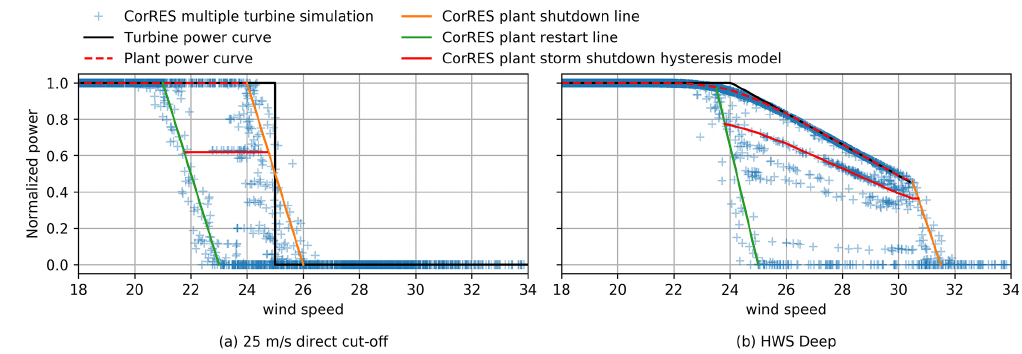
Figure 5. Plant vs. single-turbine storm shutdown for (a) 25ms − 1 direct cut-off (b) HWS Deep. Multiple turbine simulations are aggregated in 5min. The shutdown hysteresis curve (in red) is an example case where restart occurs before the entire plant has shutdown.